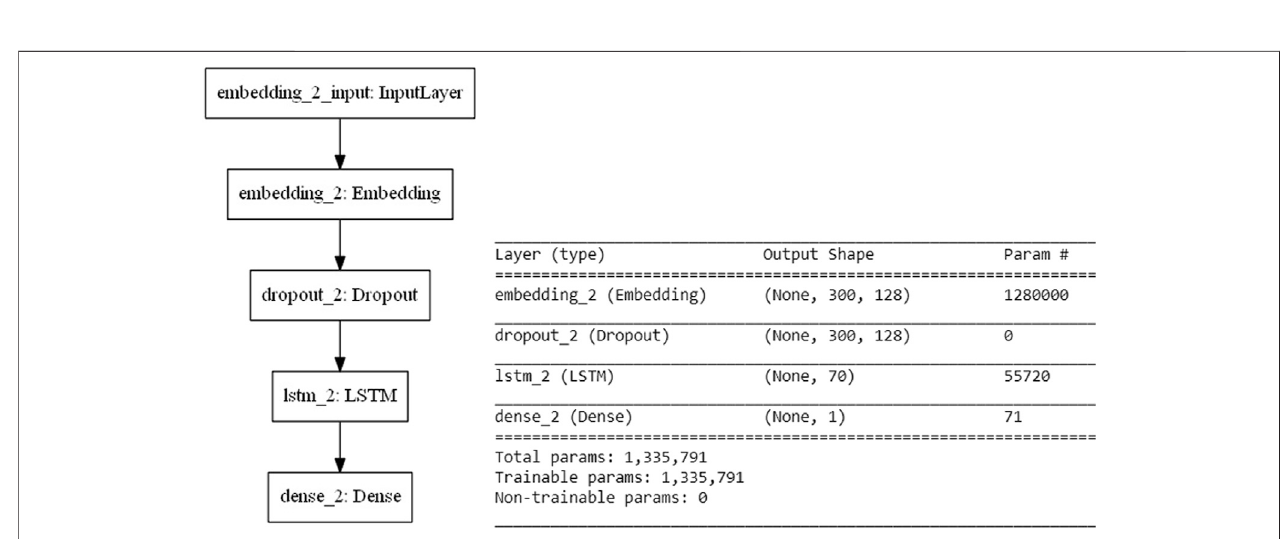
FIGURE 7 | RNN model architecture and params for classifying OCRs that mention product defects vs. do not mention product defects.